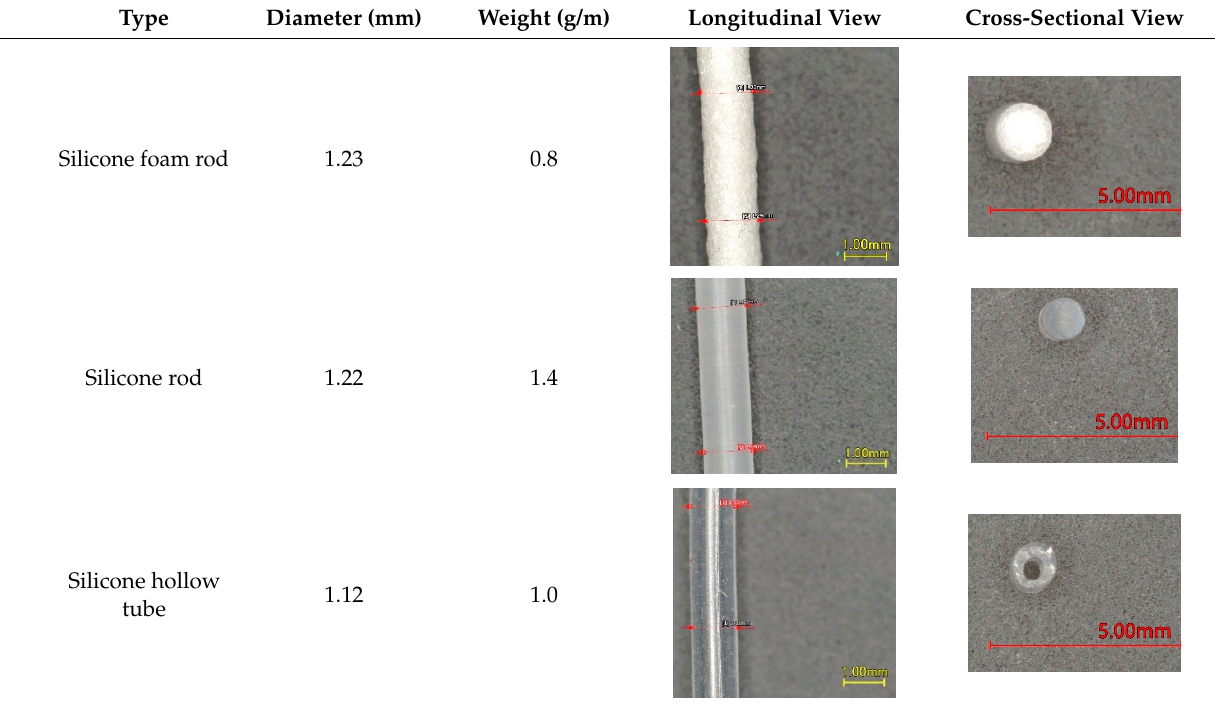
Table 1. Details of the three tubular samples.